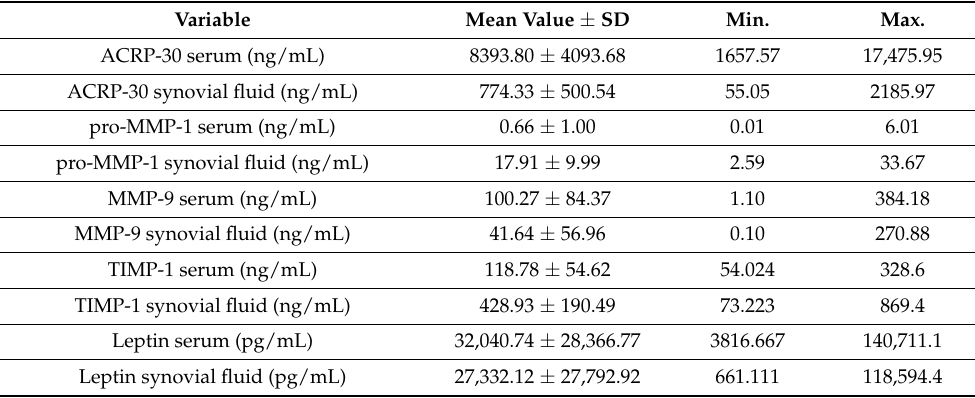
Table 2. Concentrations of the studied biomarkers in blood serum and synovial